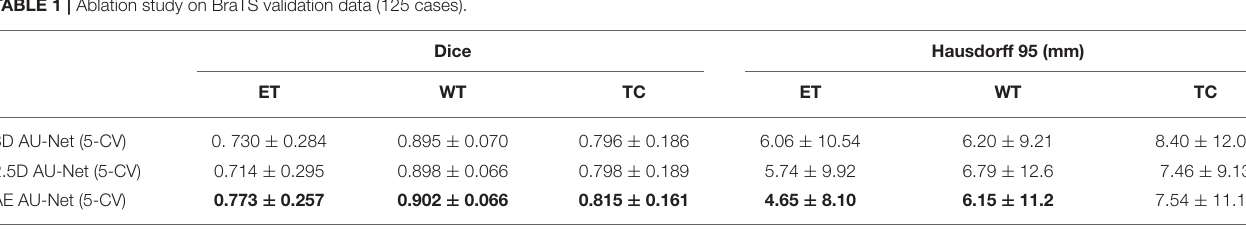
TABLE 1 | Ablation study on BraTS validation data (125 cases). Dice Hausdorff 95 (mm) ET WT TC ET WT